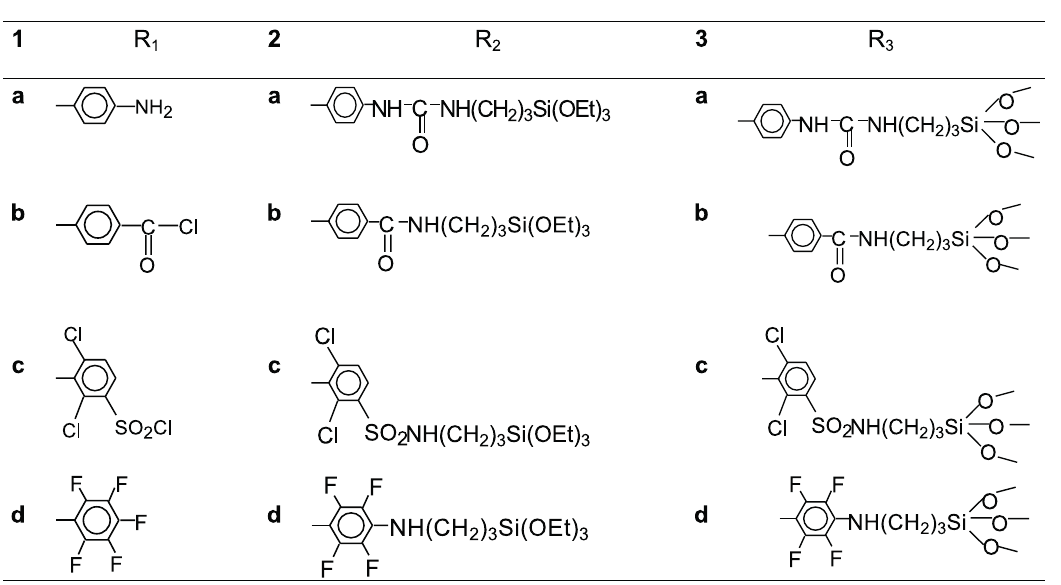
An. Acad. Bras. Ci. ,(2000) 72